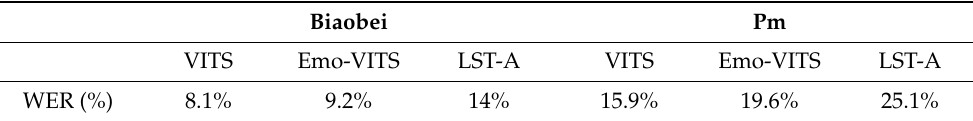
Table 1. Objective evaluation of Biaobei and Pm